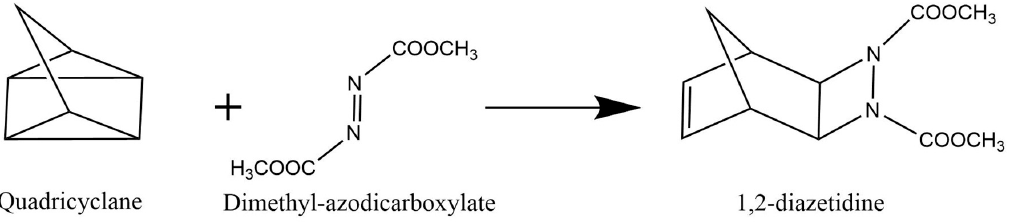
Figure 5. Reaction of quadricyclane with dimethyl azodicarboxylate to yield 1,2 ‐ diazetidine.